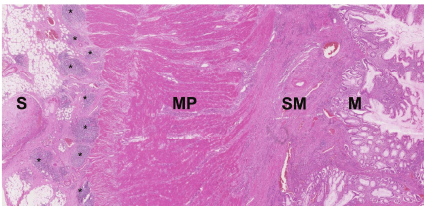
Figure 5: H&E histology slide 50x magnification showing sub- serosal lymphoid aggregates in a rosary pattern. S = serosa, ∗ = lymphoid aggregate, MP = muscularis propria, SM = submucosa, and M =